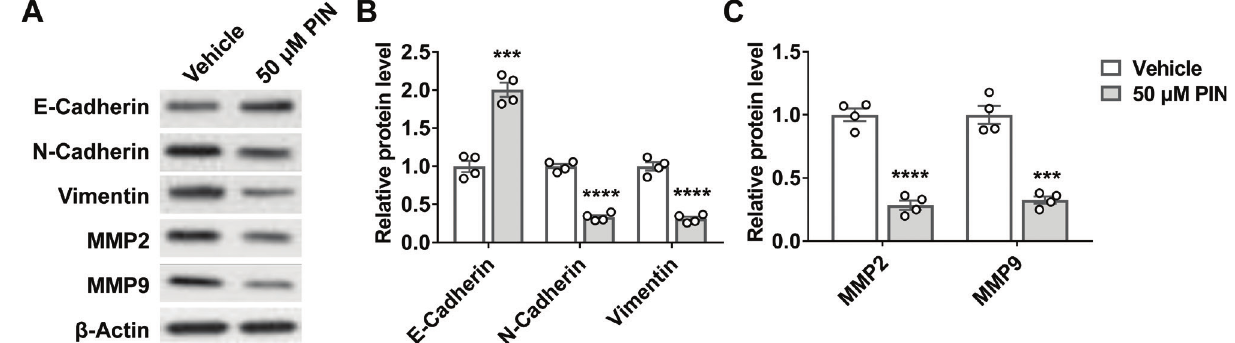
Fig. 2. Pinocembrin altered the expression of epithelial-mesenchymal transition related proteins in A549 cells. A549 cells were treated with 50 μM pinocembrin (PIN) for 24 h, and the protein levels of epithelial-mesenchymal transition proteins were deter- mined by western blot. Four wells per group. The significant difference vs control group was analyzed using two-tailed t -test. *** P < 0.001, **** P < 0.0001.